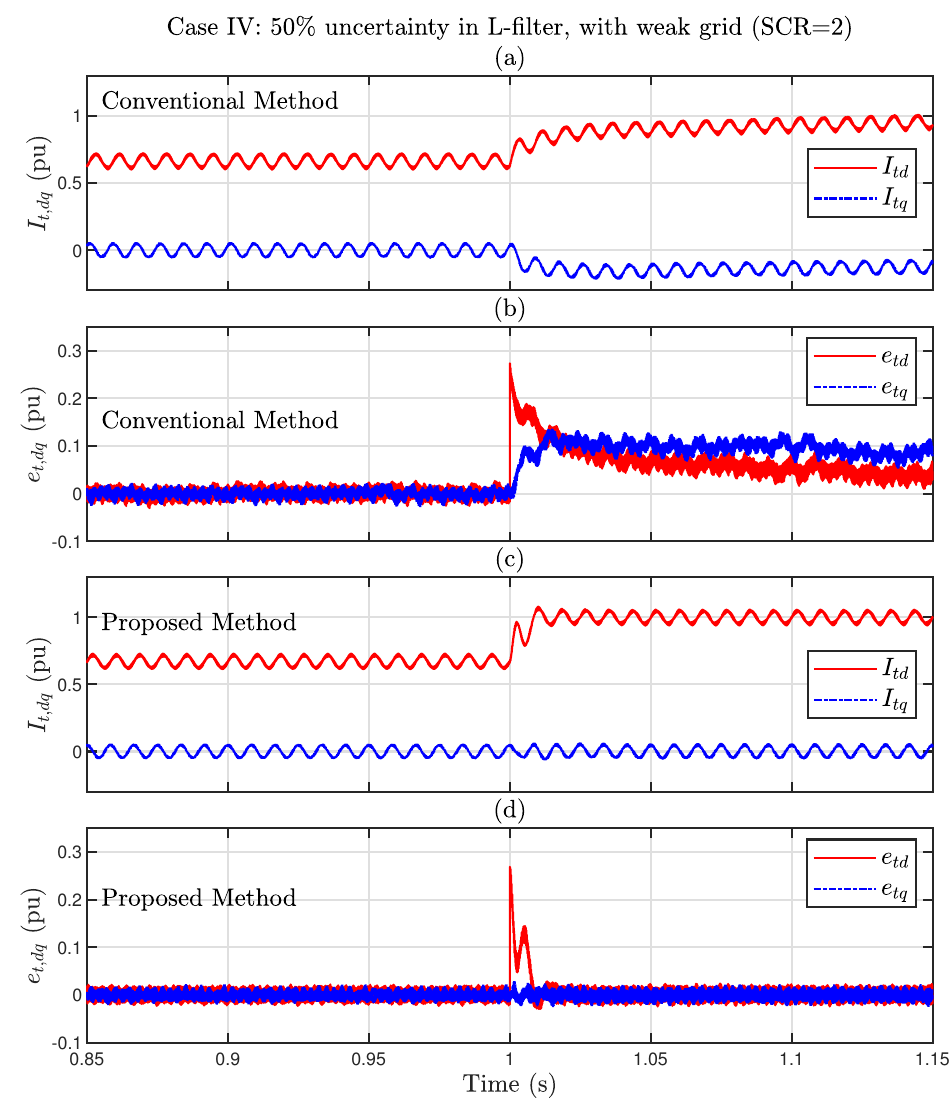
Figure 19. Comparison of the results for Case IV: dq components of the inverter currents ( I t , dq ) and error signals ( e t , dq ): ( a , b ) conventional method, and ( c , d ) proposed